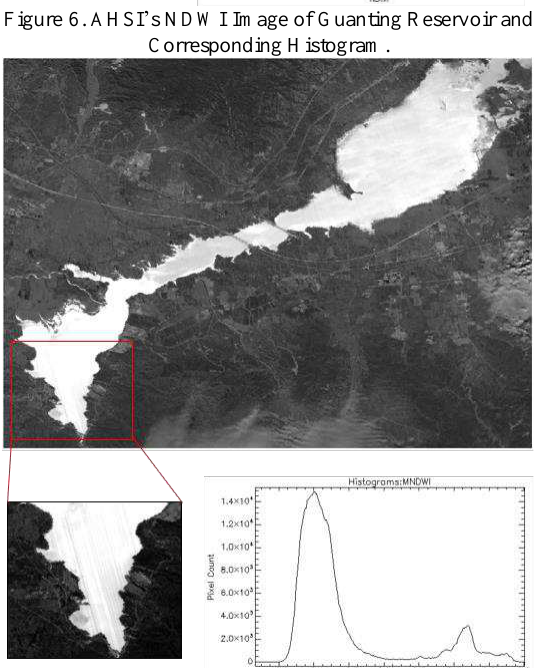
Figure 7. AHSI ’ s MNDWI Image of Guanting Reservoir and Corresponding Histogram.